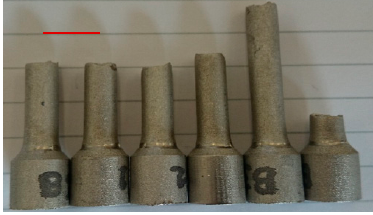
Figure 6. Set B (175 W) specimen fracture locations.